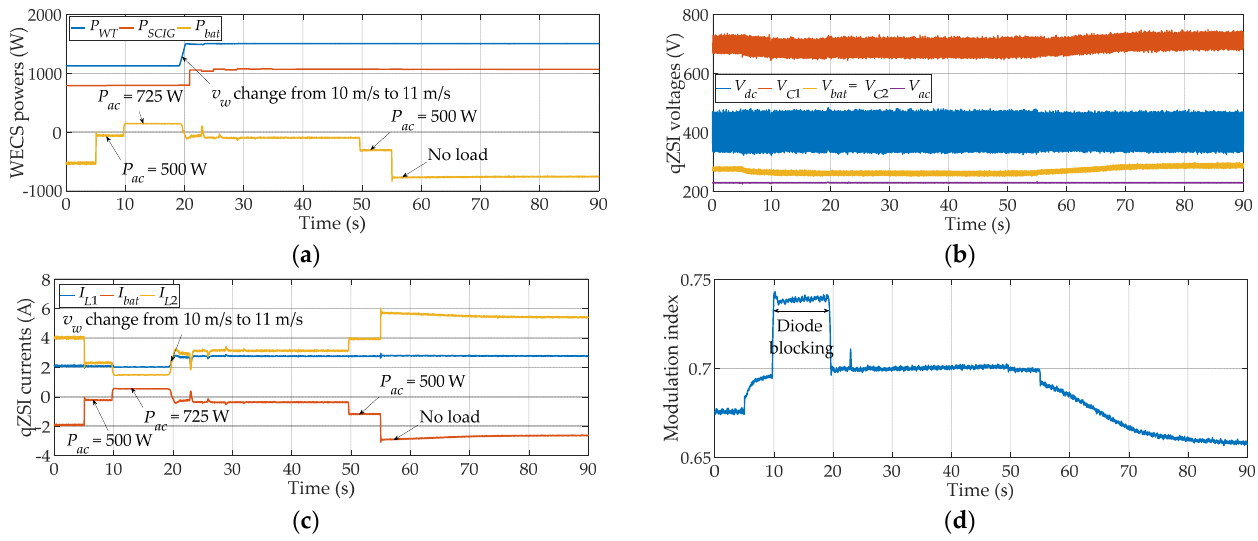
Figure 11. Dynamic responses to load and wind speed perturbations: ( a ) WECS powers; ( b ) qZSI voltages; ( c ) qZSI currents; ( d ) modulation index.